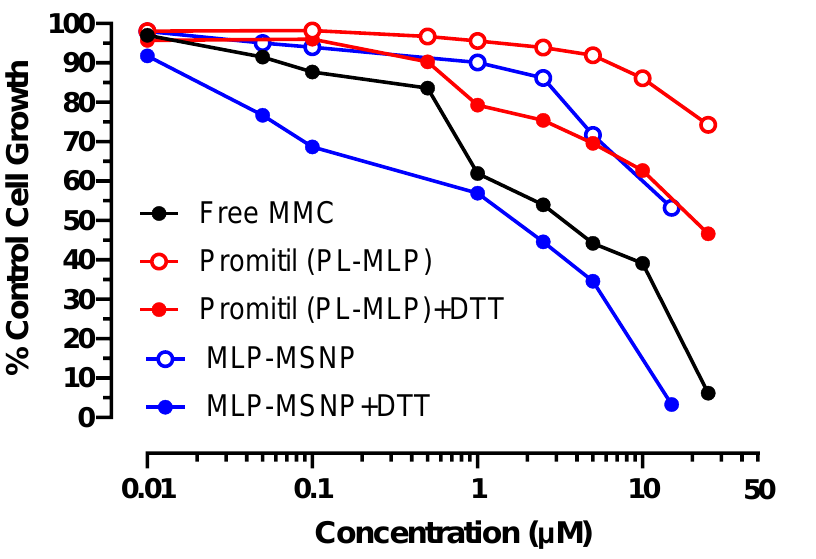
Figure 9. Cytotoxicity evaluation of Panc-1 tumor cells exposed to different concentrations of free MMC, Promitil (MLP-loaded liposomes) dispersed in medium ± DTT (0.5 mM), and MLP-loaded MSNPs dispersed in medium ± DTT (0.5 mM).